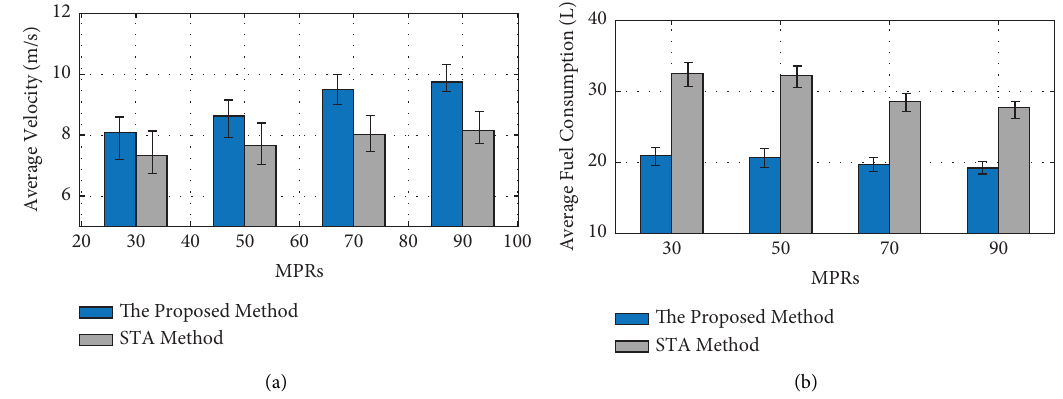
Figure 5: Comparison results of two methods. (a) Comparison results of average velocity. (b) Comparison results of average fuel